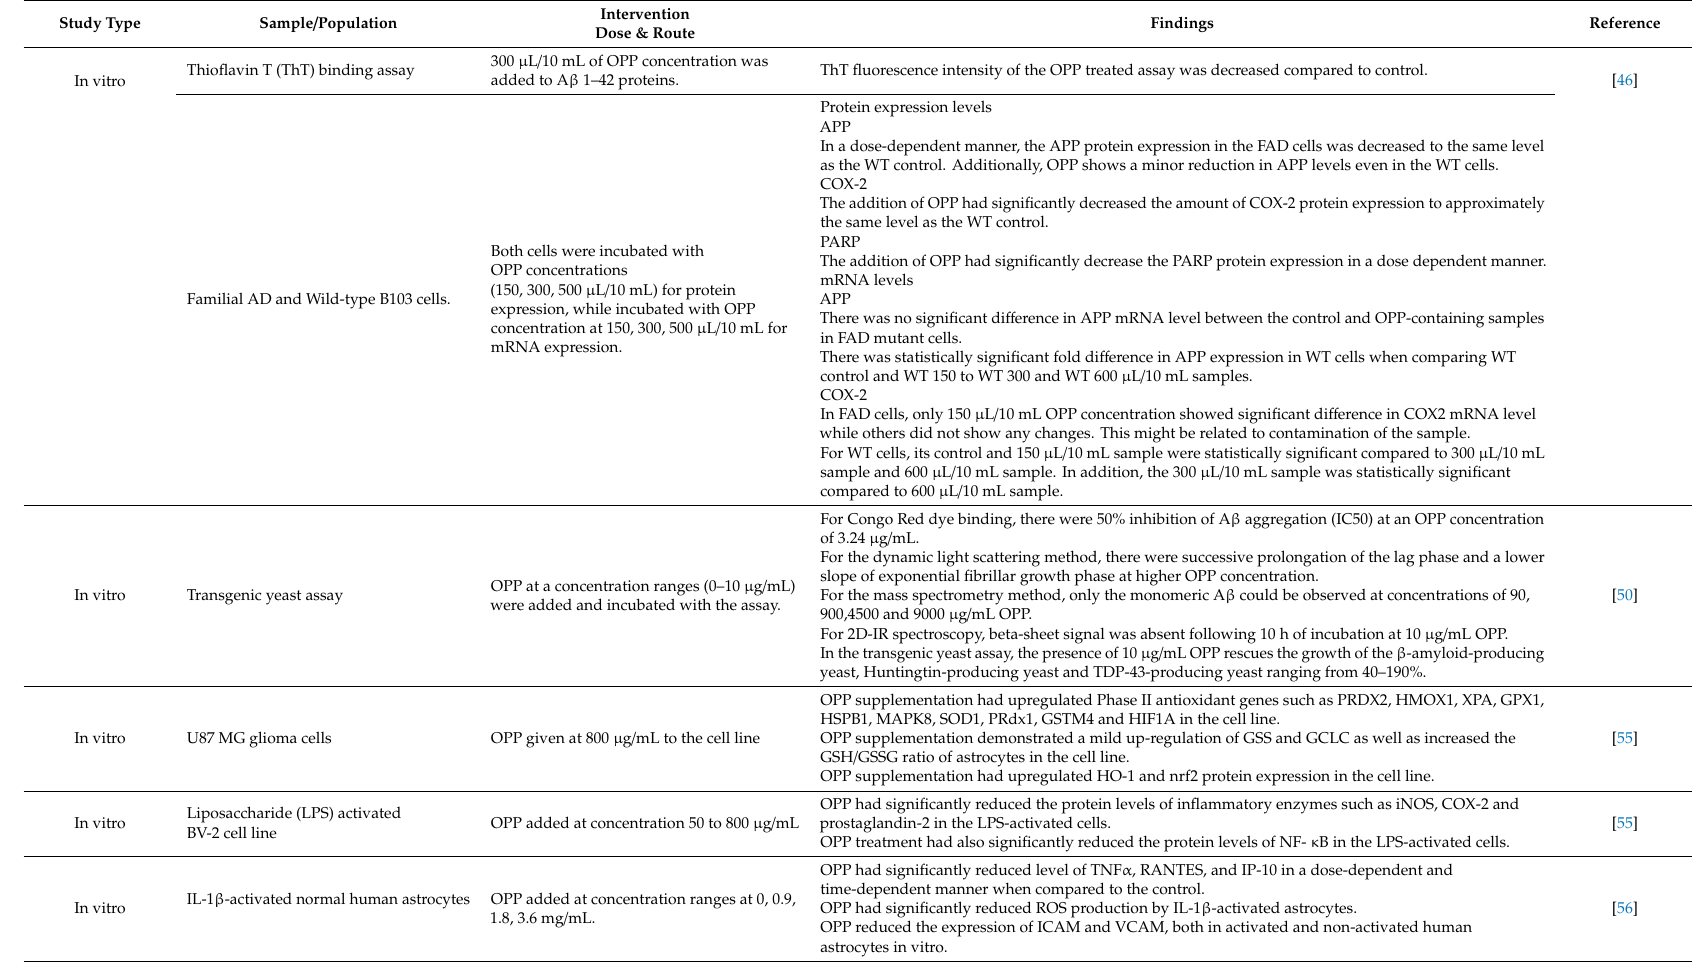
Table 1. The e ff ects of OPP related to neuronal